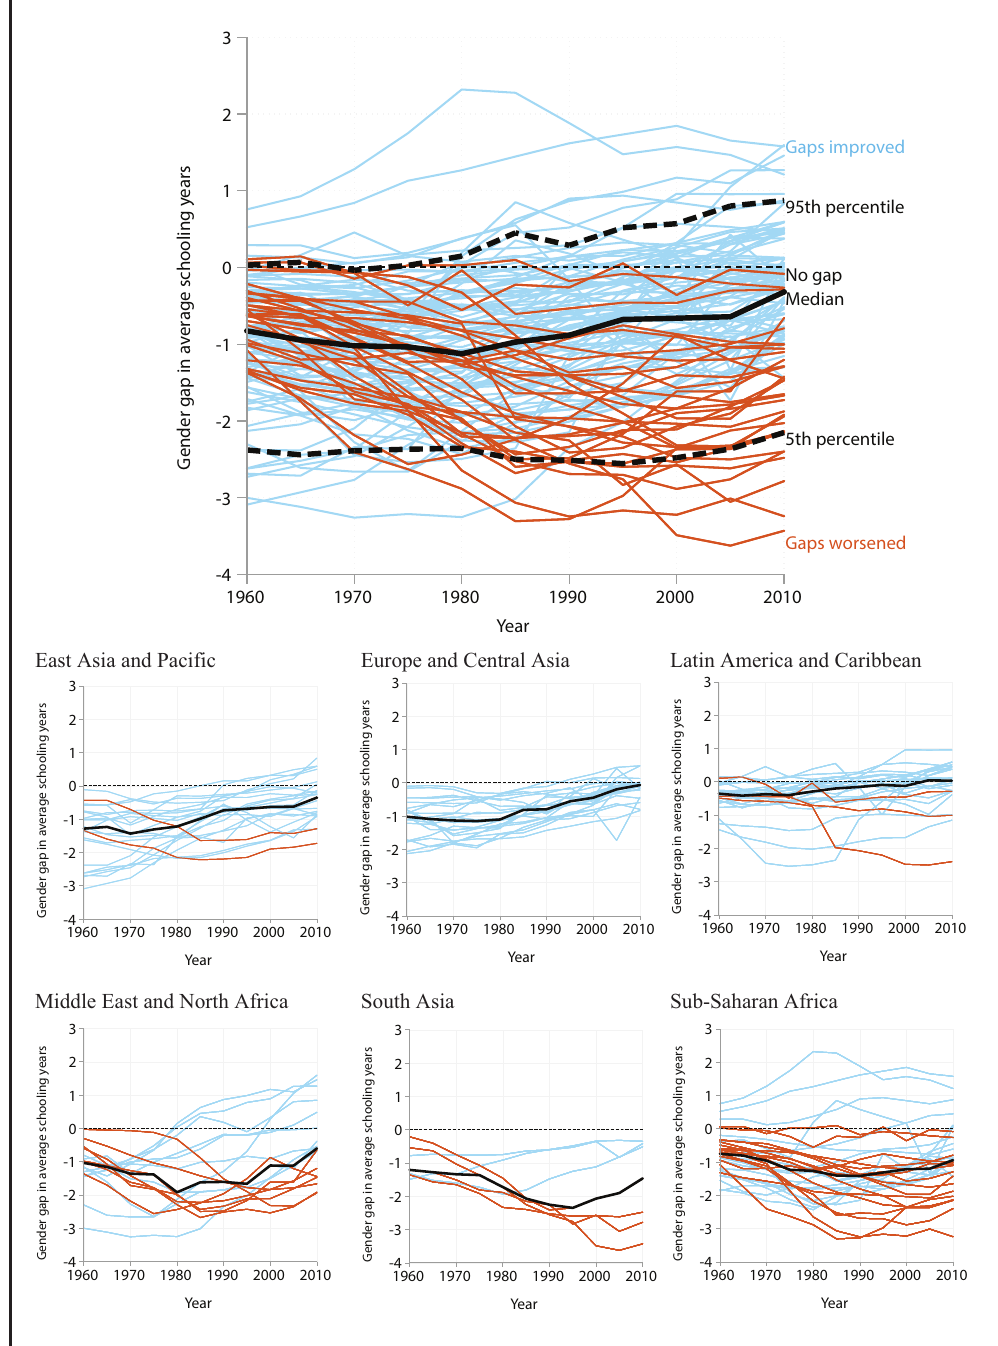
Figure 2 Change in Gender Gaps in Educational